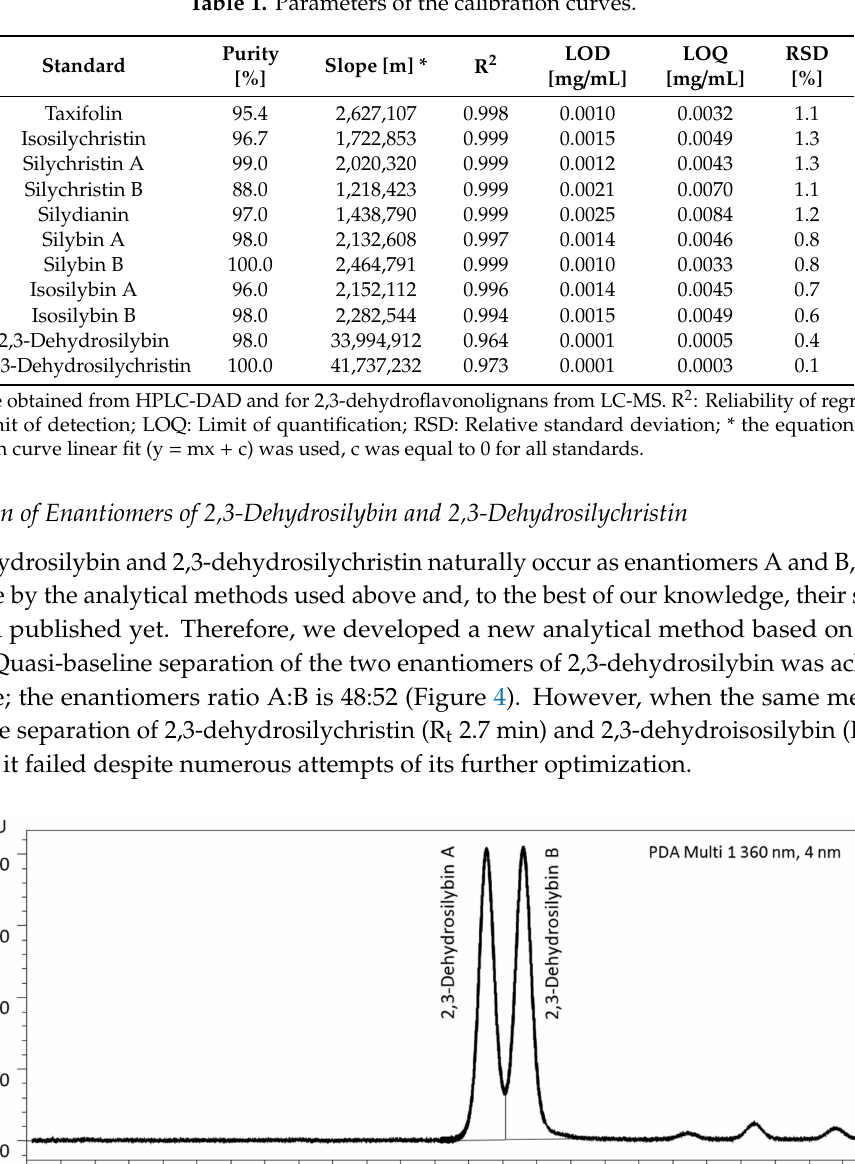
Table 1. Parameters of the calibration curves.